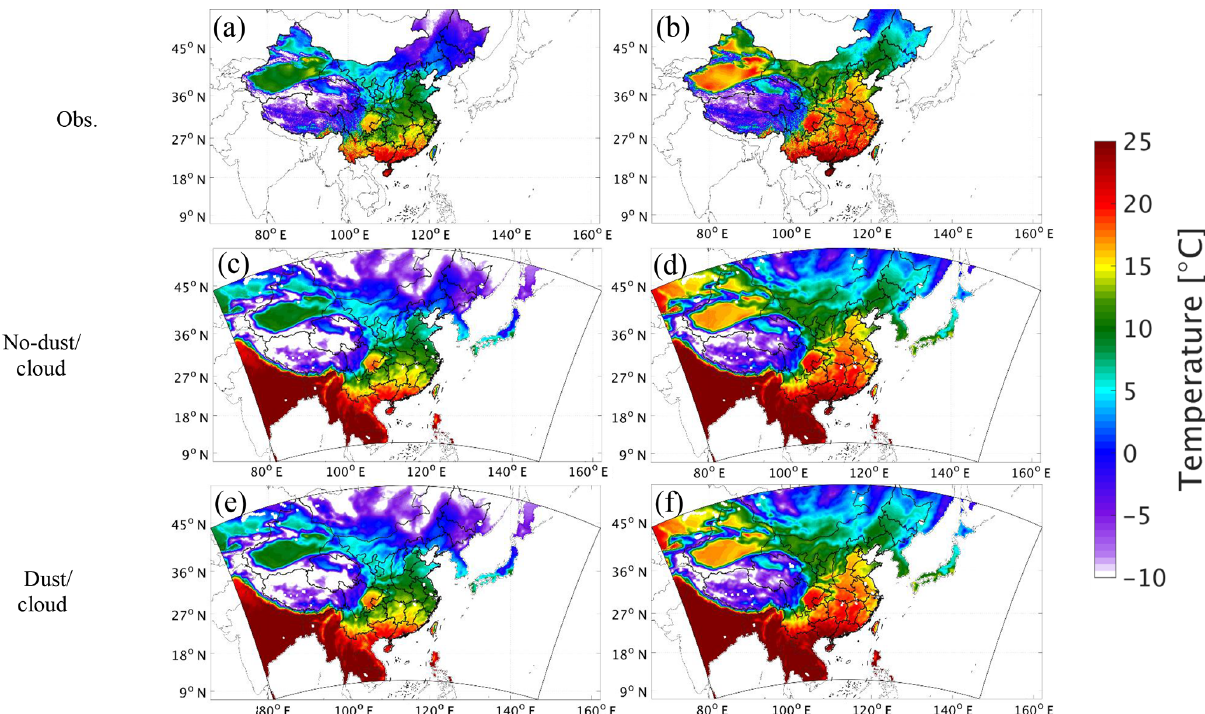
Figure 3. Spatial distributions of the average near-surface temperature from observations (a, b) , from NO-DUST/CLOUD (c, d) , and from DUST-CLOUD (e, f) during March (left panels) and April (right panels)